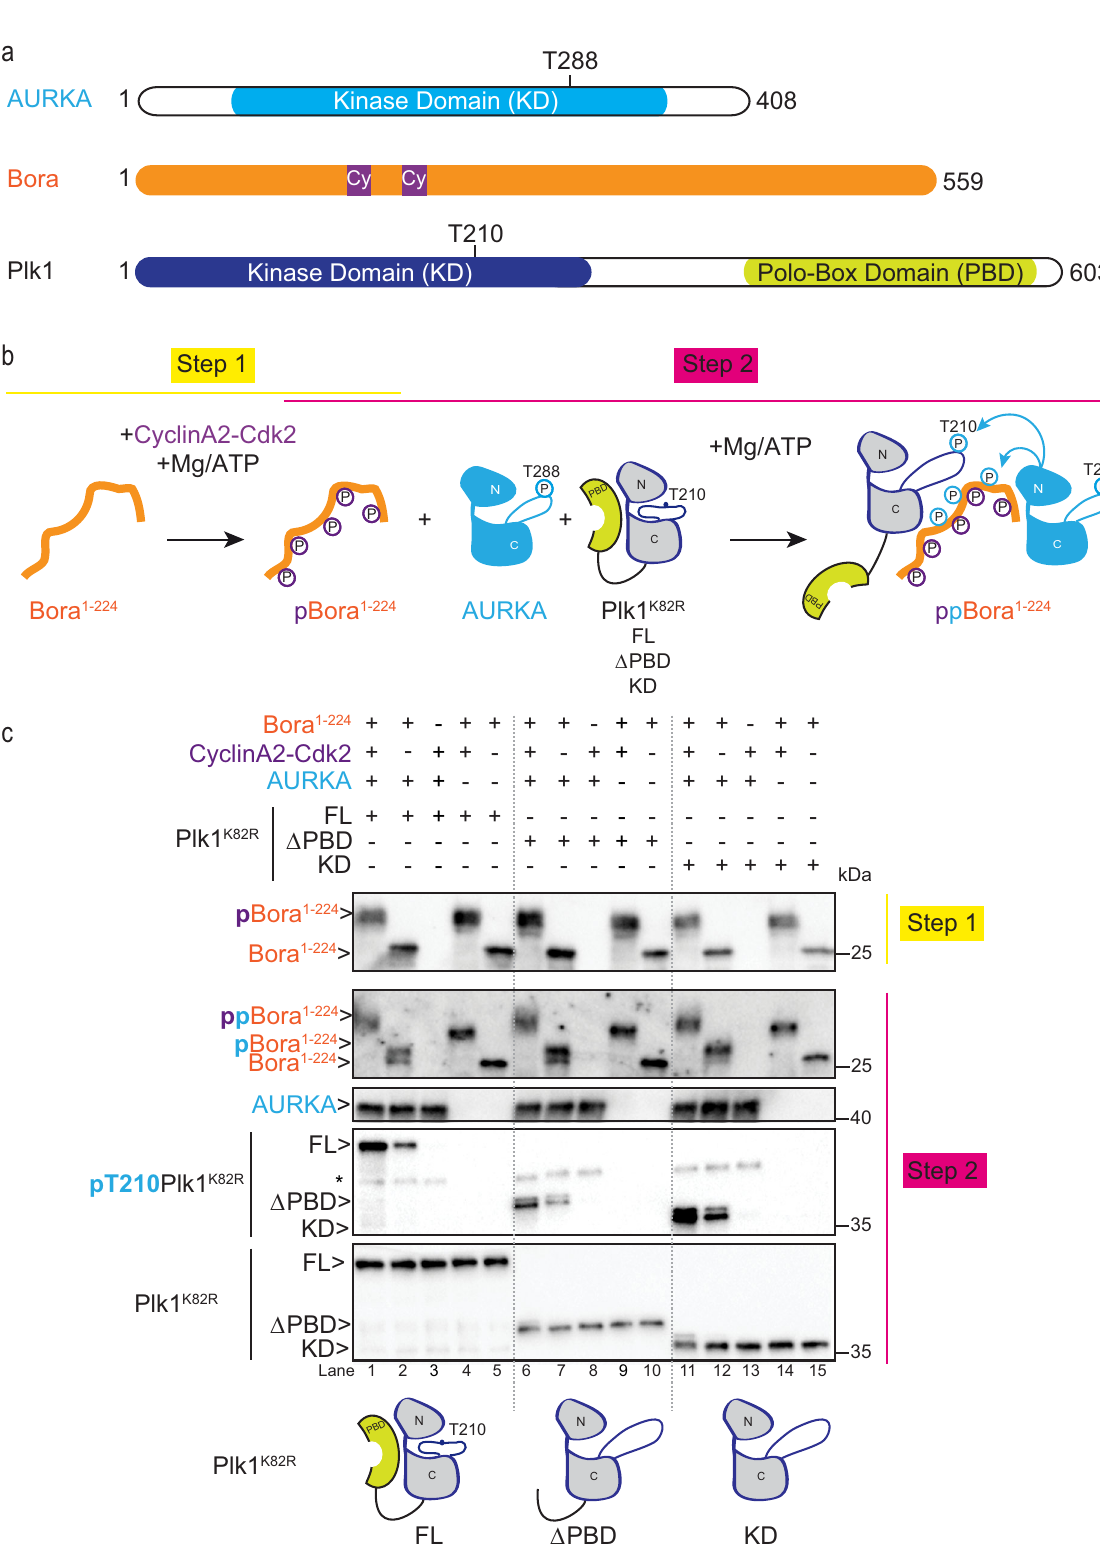
environment sampled by residues in a disordered state relative to the greater diversity of environments sampled by residues in a folded state. Phosphorylation of Bora 1 – 224 by Cyclin-Cdk on an average of 8 to 10 S/T-P sites (Supplementary Fig. 2a, right panel), led to the expected down- fi eld shift of resonance peaks corresponding to phosphorylated amino acids. The majority of